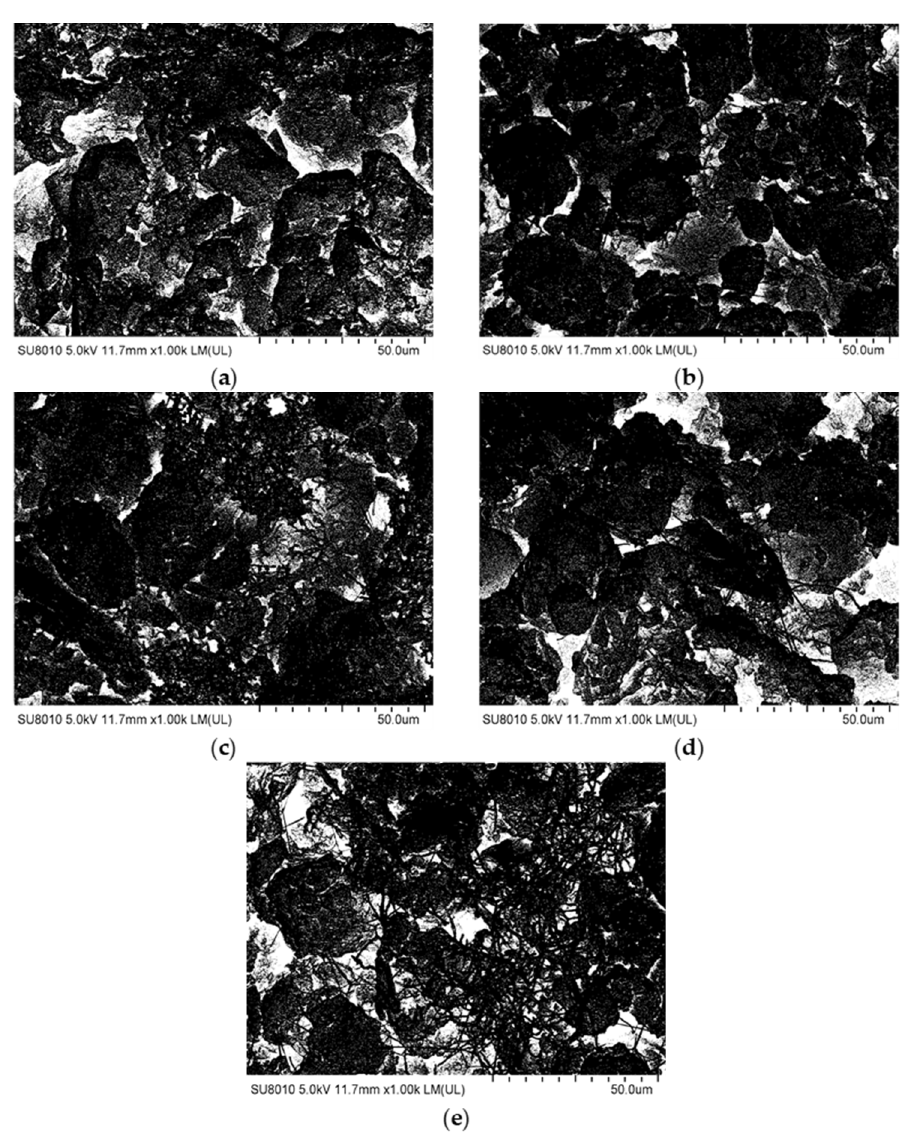
Figure 13. Binary image of improved loess with different CLS contents. ( a ) Binary image of untreated loess; ( b ) binary image of 1% CLS content; ( c ) binary image of 3% CLS content; ( d ) binary image of 5% CLS content; ( e ) binary image of 7% CLS content.